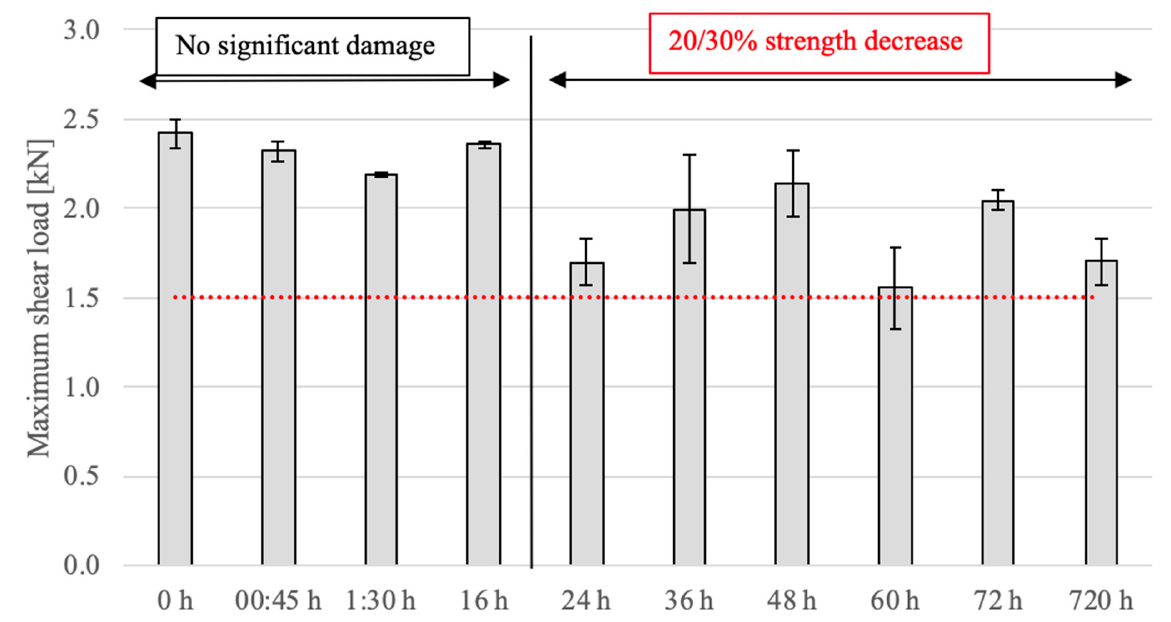
Figure 14. Maximum shear strength of RJS specimens continuously immersed in petroleum oil. The red dotted line represents the threshold value for the RJS specimen’s minimum allowed joint strength (1.5 kN).